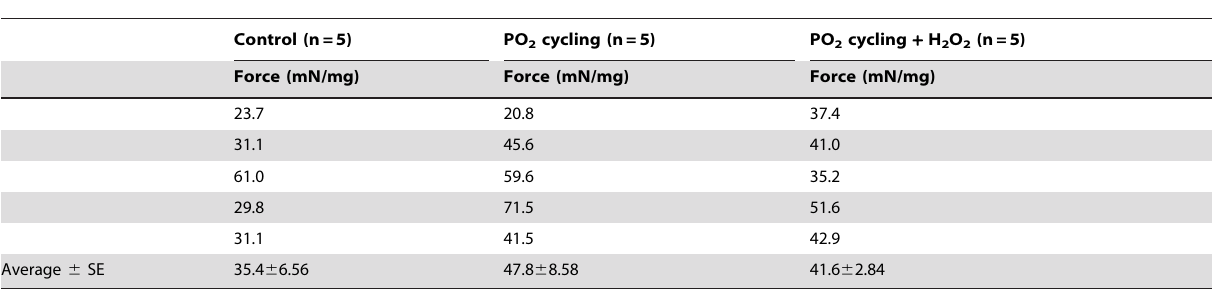
Table 1. % of maximal force prior to low PO 2